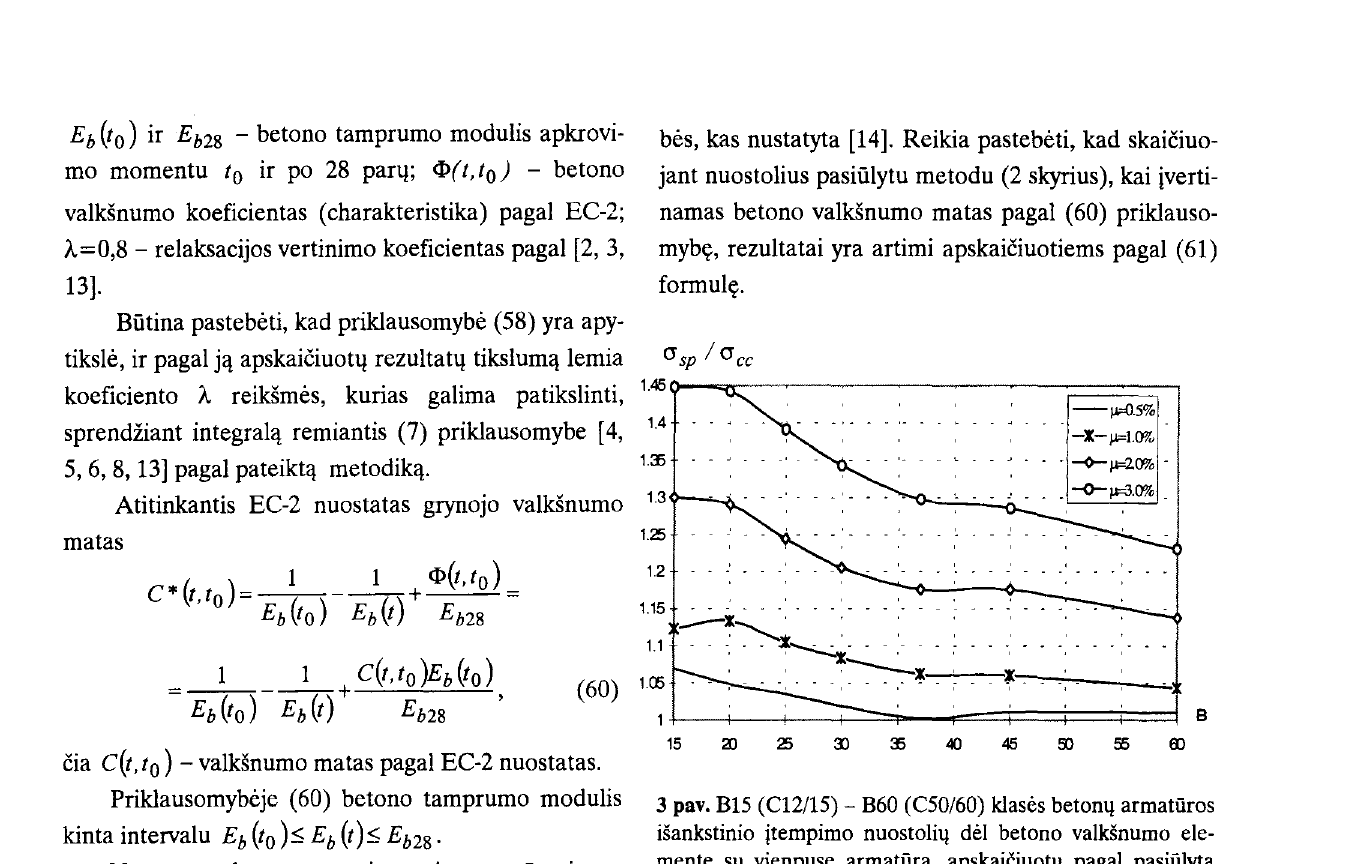
(elemento skerspjiivio aukStis h=0,5 m, plotis b=0,3 m, pra